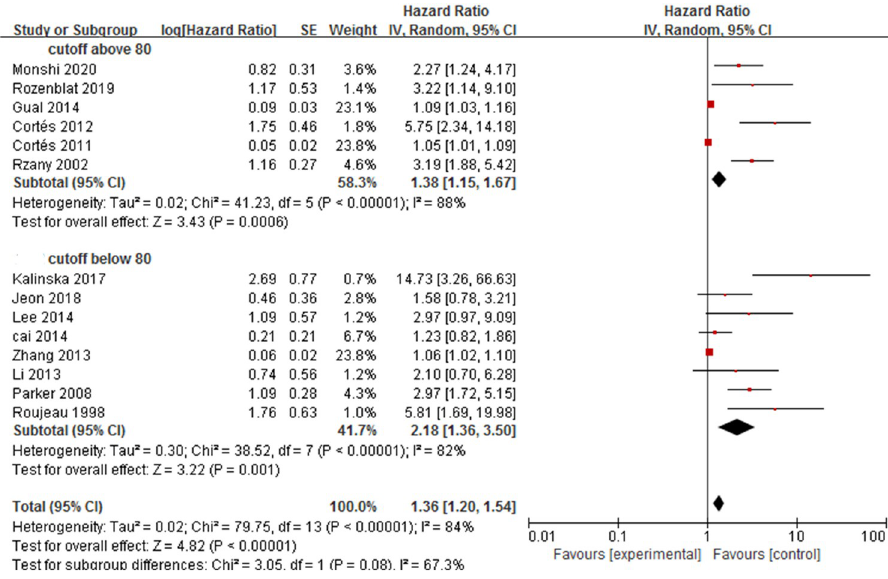
Fig 3. Forest plot of the subgroup analysis of the association between advanced age and bullous pemphigoid mortality.